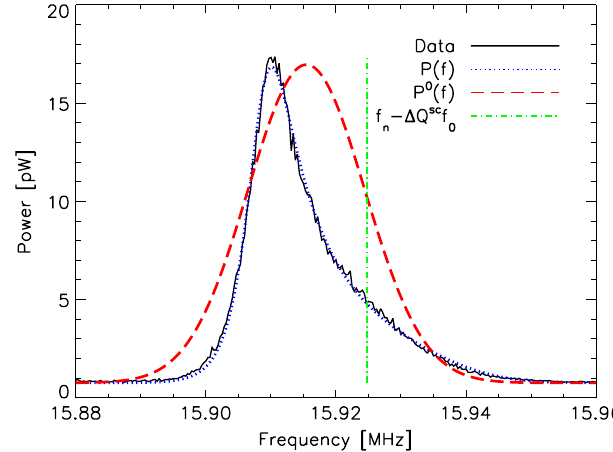
FIG. 8. (Color) Lower vertical sideband of the 75th harmonic measured in SIS-18. The measured data is plotted as a black curve. The dotted blue curve represents the analytic expression Eq. (17) with fitted parameters. The dashed red curve shows the (cid:4) 0 (maximum adjusted). expected Schottky spectrum for U sc The vertical green line indicates the incoherent frequency (cid:5) (cid:2) Q sc f f shifted by space n; (cid:5) 0